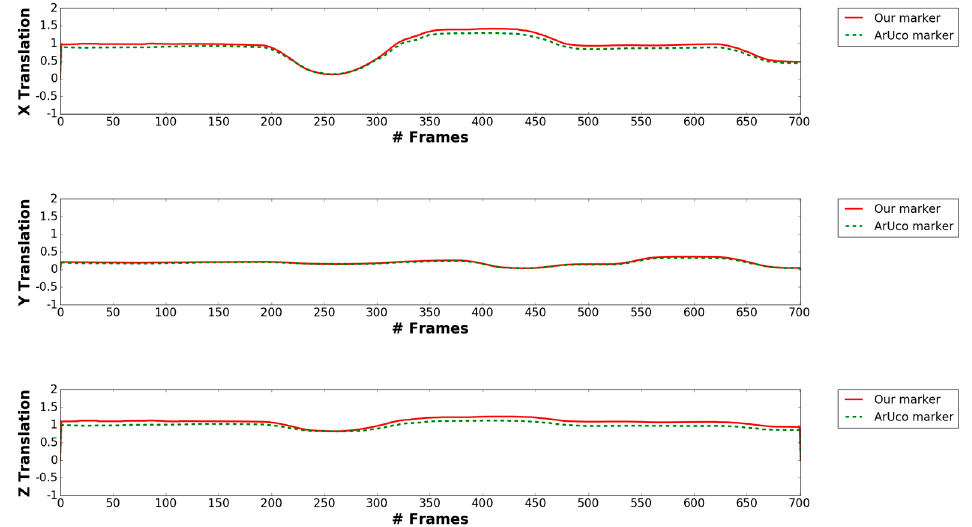
Figure 19. Comparison between estimated X, Y, Z translation of our marker and ArUco marker.